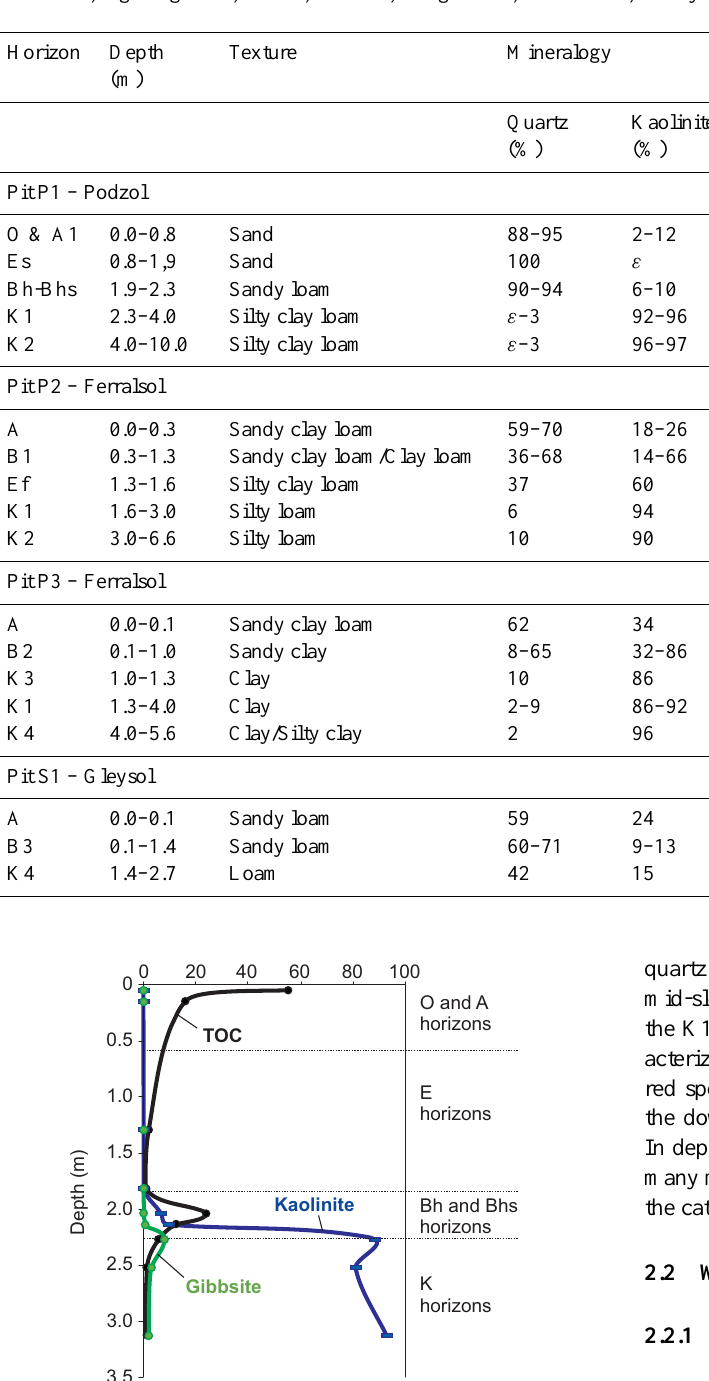
Table 1. Minerals identified in the soil material. Pits and horizon are located on Fig. 2. A: anatase, M: muscovite, V: vermiculite, Mc: microcline, Mg: magnetite, I: illite, R: rutile, Go: goethite, H: hematite, ε : very small amounts.